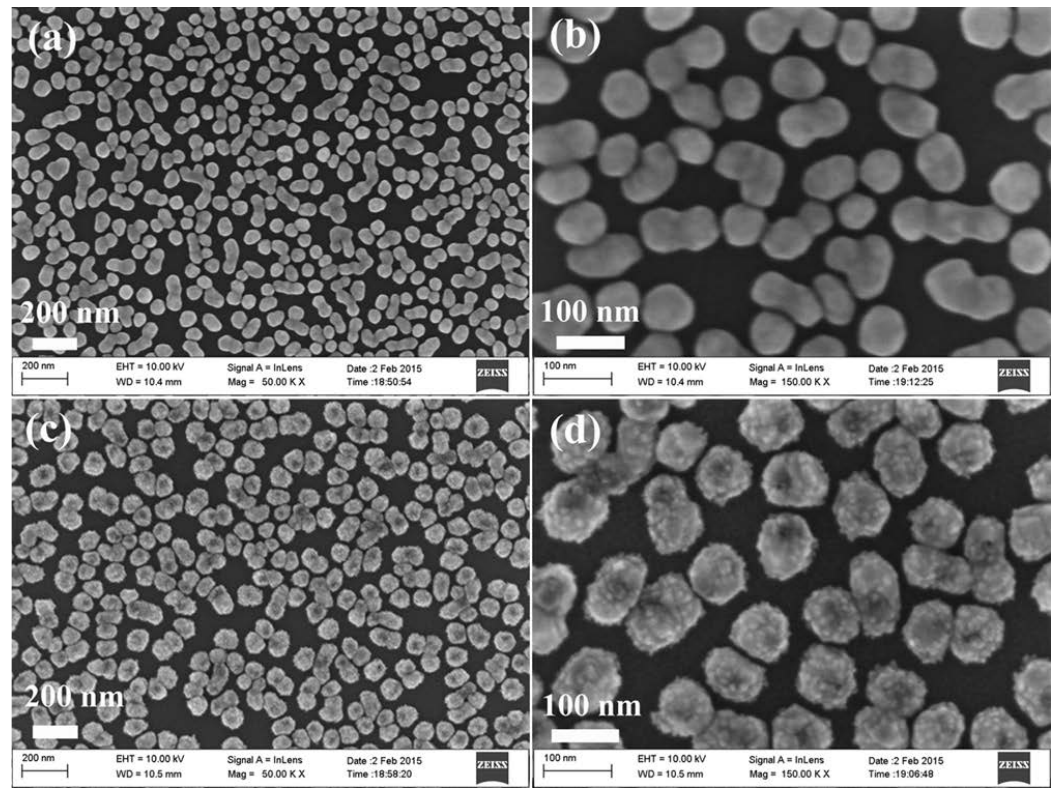
Figure 1. ( a ) Low magnification and ( b ) high magnification SEM images of Ag nanoparticles grafted on the Ge wafer; ( c ) Low magnification and ( d ) high magnification SEM images of Ag–Pt nanoparticles grafted on the Ge wafer.